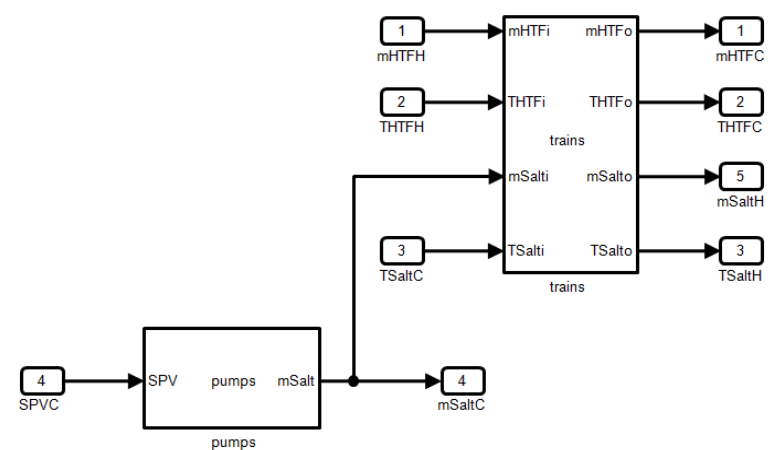
Figure 7. Diagram for TES charge process.